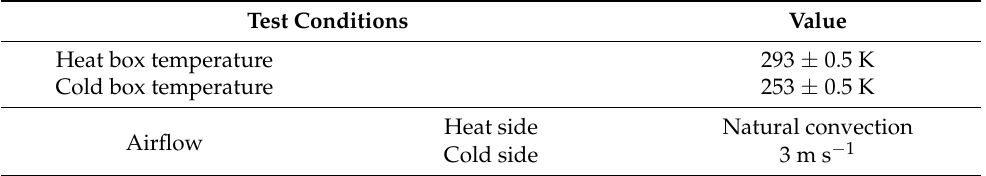
Table 5. Thermal performance test